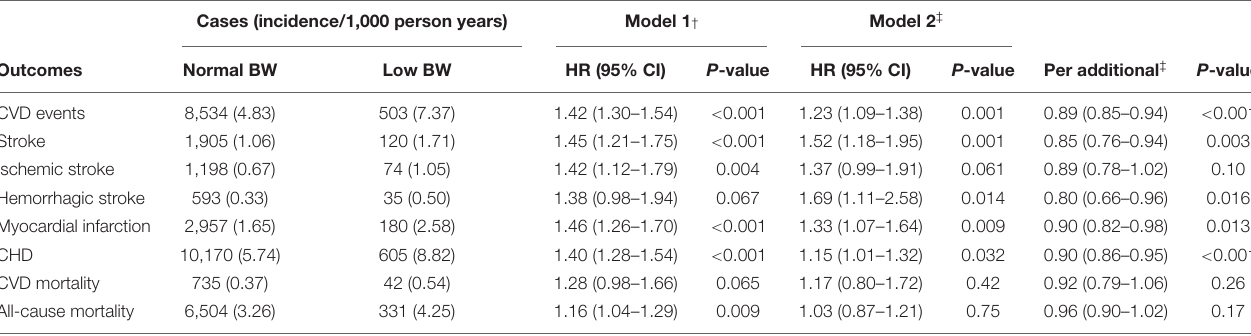
TABLE 2 | Association between low birth weight and risk of cardiovascular outcomes. Cases (incidence/1,000 person years)